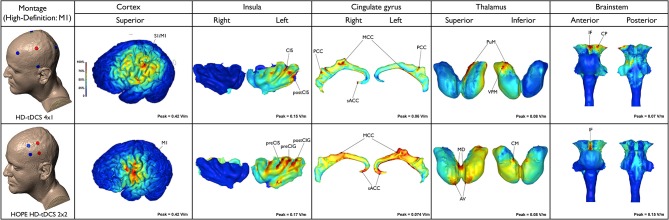
Electric field maps produced by two methods of high-definition (HD)-tDCS: HD-tDCS 4 × 1 and H.O.P.E. HD-tDCS 2 × 2 (first column from the top to the bottom) in outer (second column) and inner structures (third to sixth, from the left to the right).